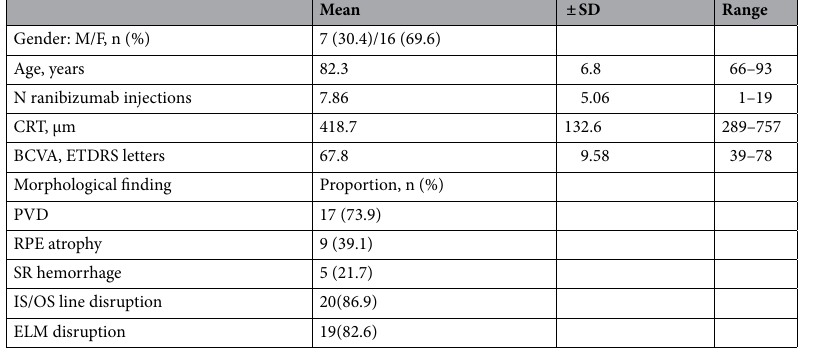
Table 1. Patient demographics and baseline characteristics (n = 23). F female, M male, N number, NA not applicable, SD standard deviation, CRT central retinal thickness, BCVA best-corrected visual acuity, ETDRS Early Treatment Diabetic Retinopathy Study, PVD posterior vitreous detachment, RPE retinal pigment epithelium, SR sub-retinal, IS/OS photoreceptor inner/outer segment (IS/OS) junction line, ELM external limiting membrane.